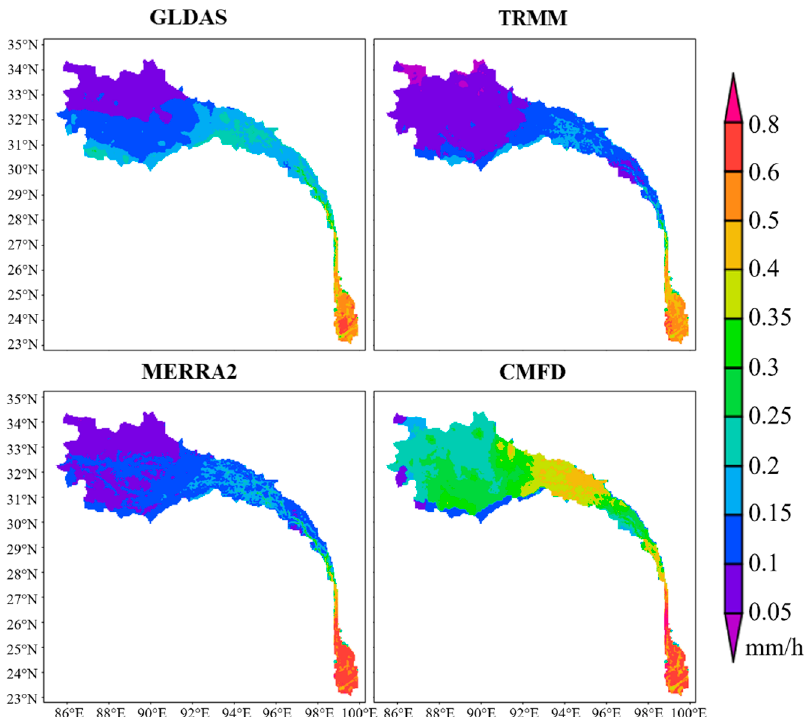
Figure 9. Mean spatial distribution of corrected precipitation from four products during the monsoon season.